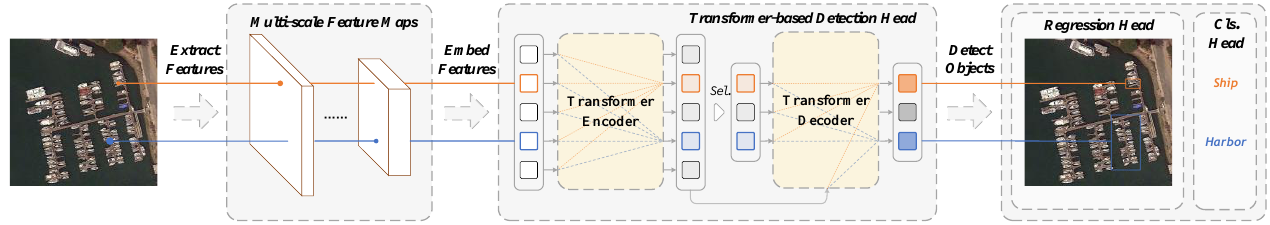
Figure 1. The overview architecture of the proposed Transformer-based RSI object-detection frame- work.